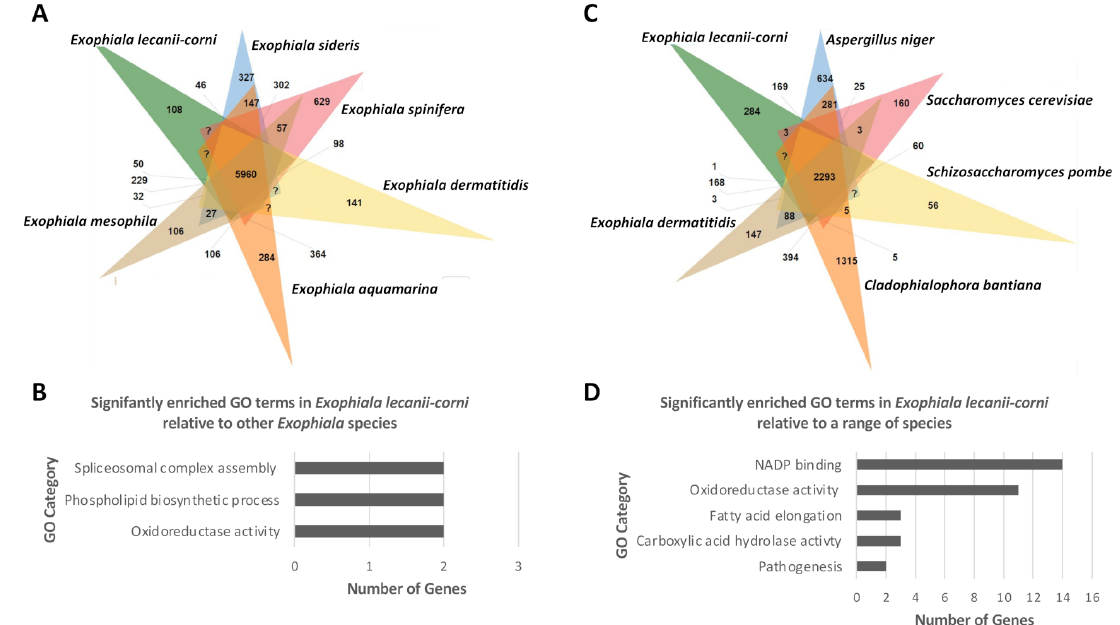
Figure 7. Venn diagrams displaying the distribution of shared orthologous gene clusters among ( A ) E. lecanii-corni and other Exophiala species, and ( C ) E. lecanii-corni , E. dermatitidis , C. bantiana , S. cerevisiae , S. pombe , and A. niger , as predicted using OrthoVenn. Significantly enriched GO categories associated with ( B ) the 108 gene cluster families that are specific to E. lecanii corni relative to E. dermatitidis , E. sideris , E. spinifera , E. aquamarina , and E. mesophila , and ( D ) the 284 gene cluster families that are specific to E. lecanii corni relative to E. dermatitidis , C. bantiana , S. cerevisiae , S. pombe , and A. niger ( p < 0.05).